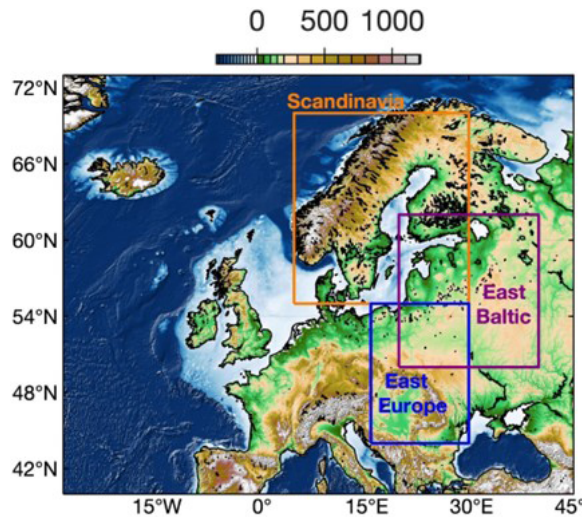
Figure 1. Map showing the location of the three regions of interest: Scandinavia (orange), East Baltic (purple) and East Europe